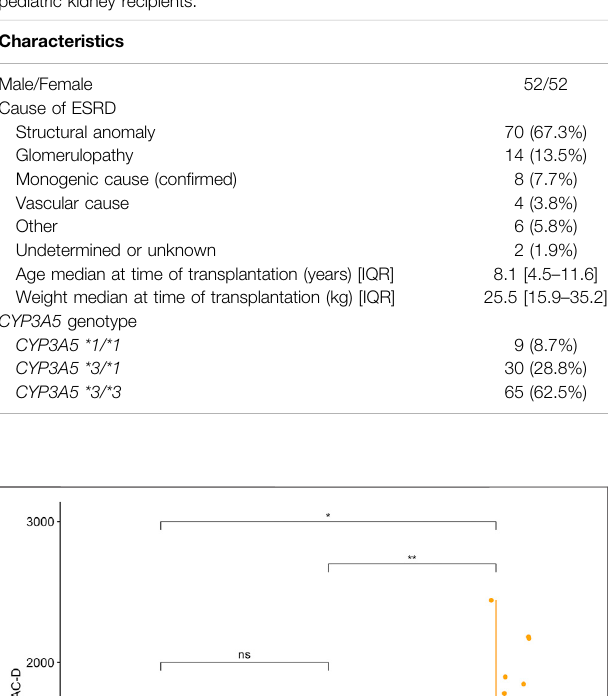
TABLE 1 | Basic clinical characteristics and CYP3A5 genotype of the 104 pediatric kidney recipients.